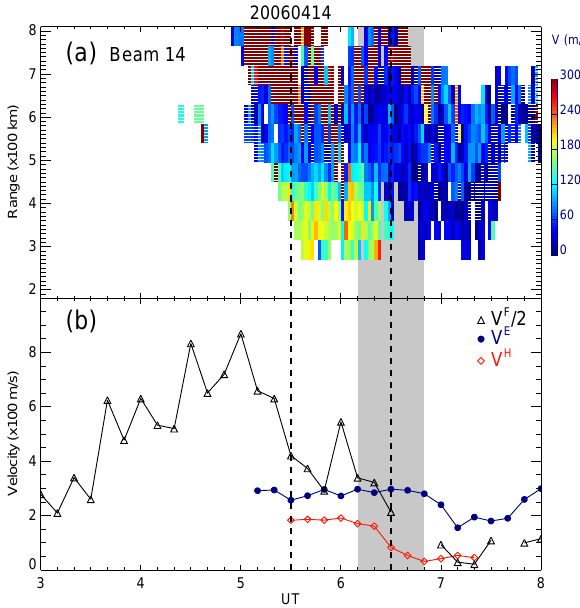
Fig. 10. Storm-time velocities measured by the Bruny Island radar on 14 April 2006. The top panel is a range-time-intensity (velocity) plot showing the Doppler velocity data in beam 14. The colour scale is shown on the right again with cells filled with colour (horizon- tal lines) representing negative (positive) Doppler velocities. The bottom panel shows time variation of the maximum F-region veloc- ity V F divided by 2 (triangles), maximum E-region velocity V E (circles), and mean maximum velocity at closer ranges r ≤ 405km V H (diamonds). The dashed lines indicate the interval 05:30– 06:30UT during which the HAIR-like echoes were observed. The grey rectangle corresponds to the 4 frames shown in Fig. 9 (06:10–